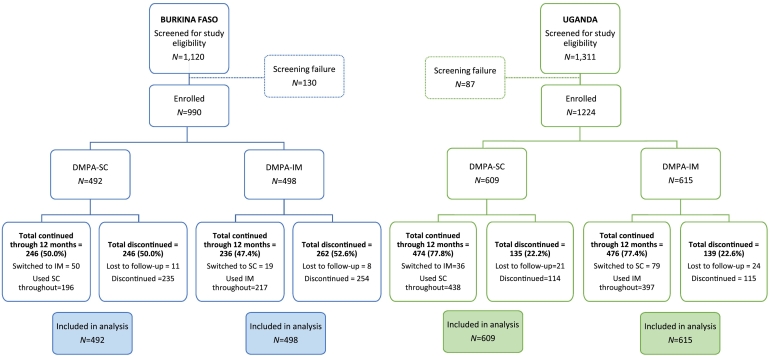
Participant flow diagram for DMPA-SC and DMPA-IM users enrolled in the study, and injectable continuation rates in Burkina Faso and Uganda.